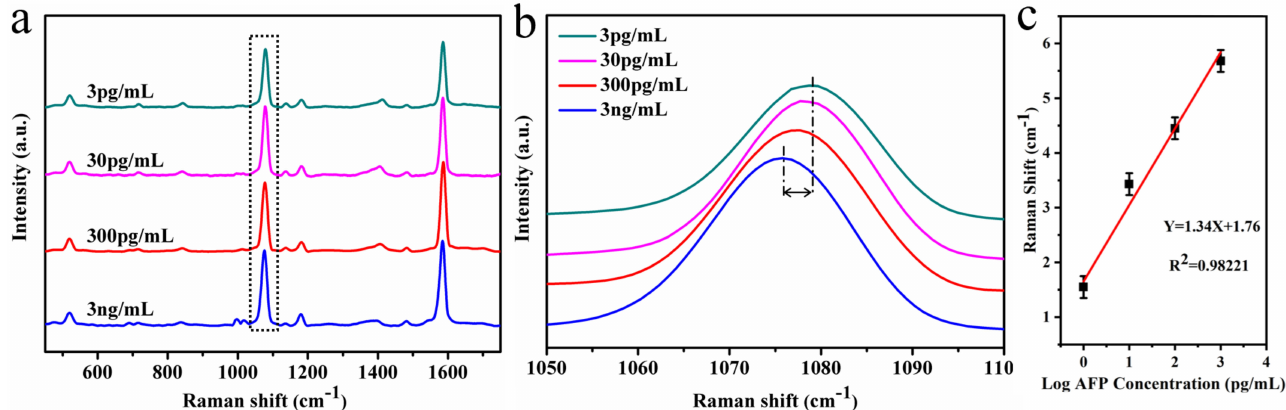
Figure 3. ( a ) SERS spectrum of an active subtrate decorated with different concentrations of AFP antigen. ( b ) A magnified image of the marked area in the dotted line in Figure 3a. ( c ) Function plot of the AFP concentration logarithm and the 1075 cm − 1 peak frequency